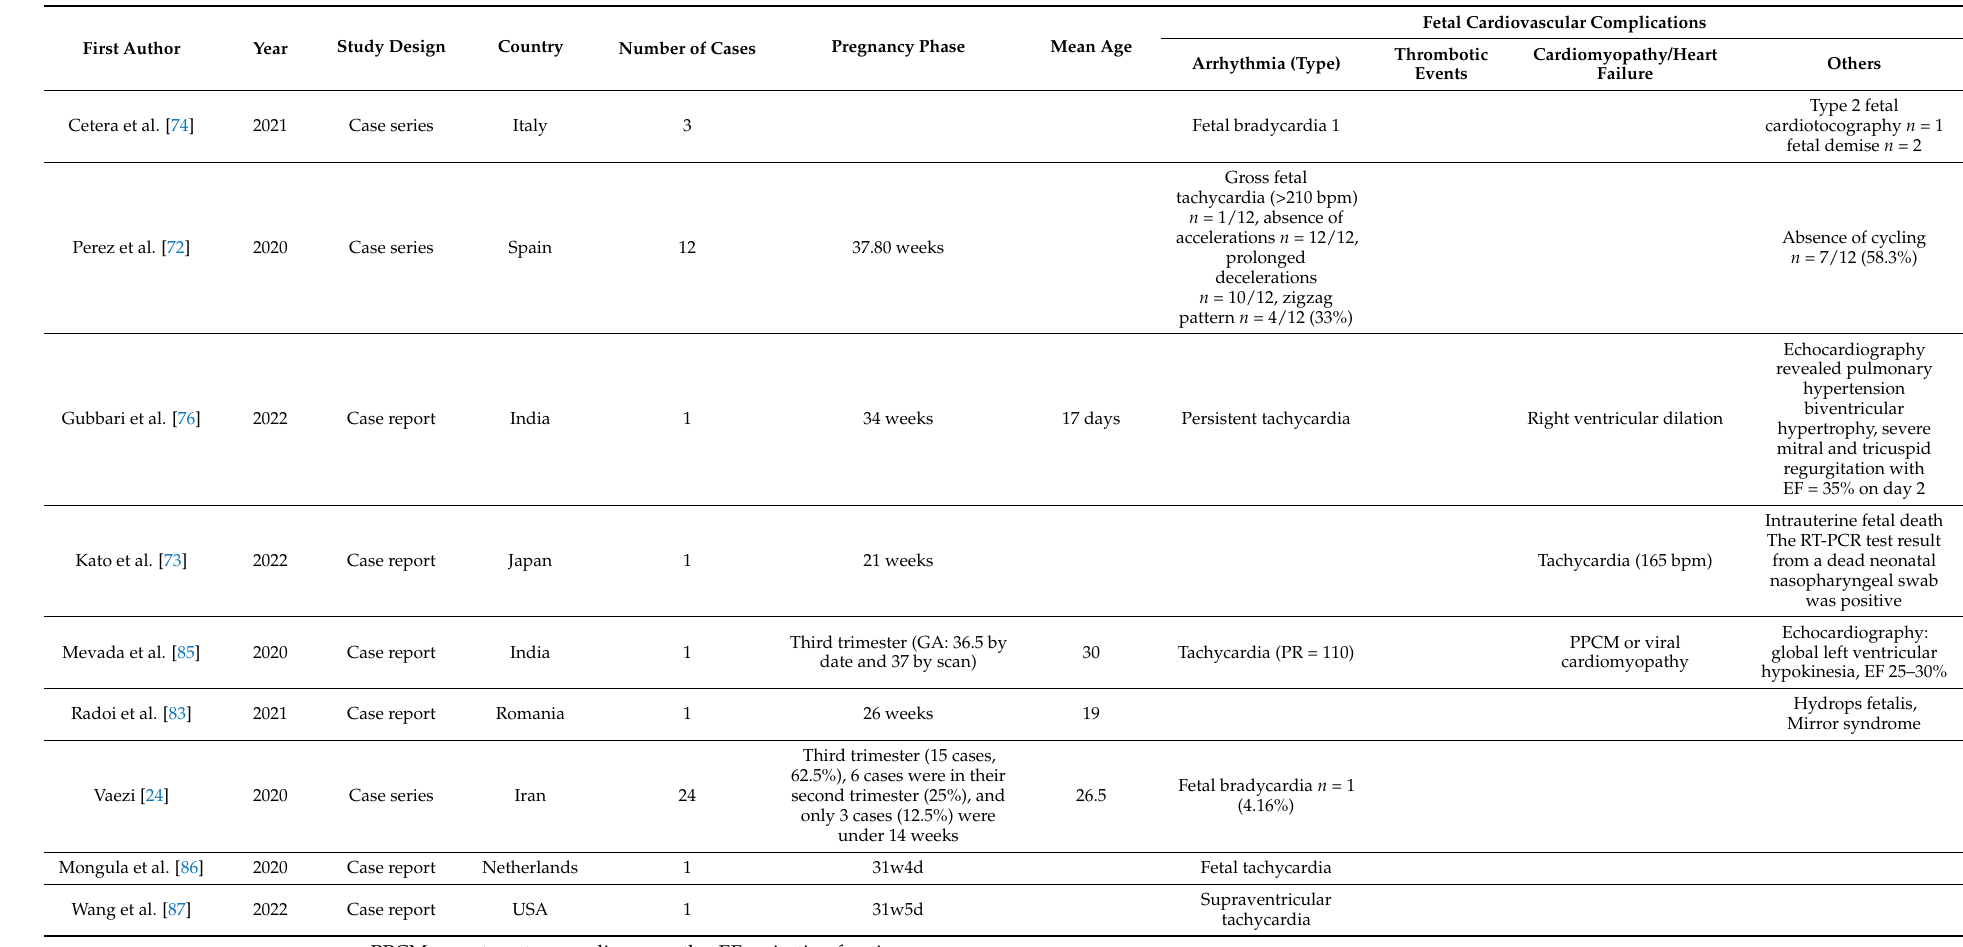
Table 4. Characteristics and fetal outcomes of the included case report/case series